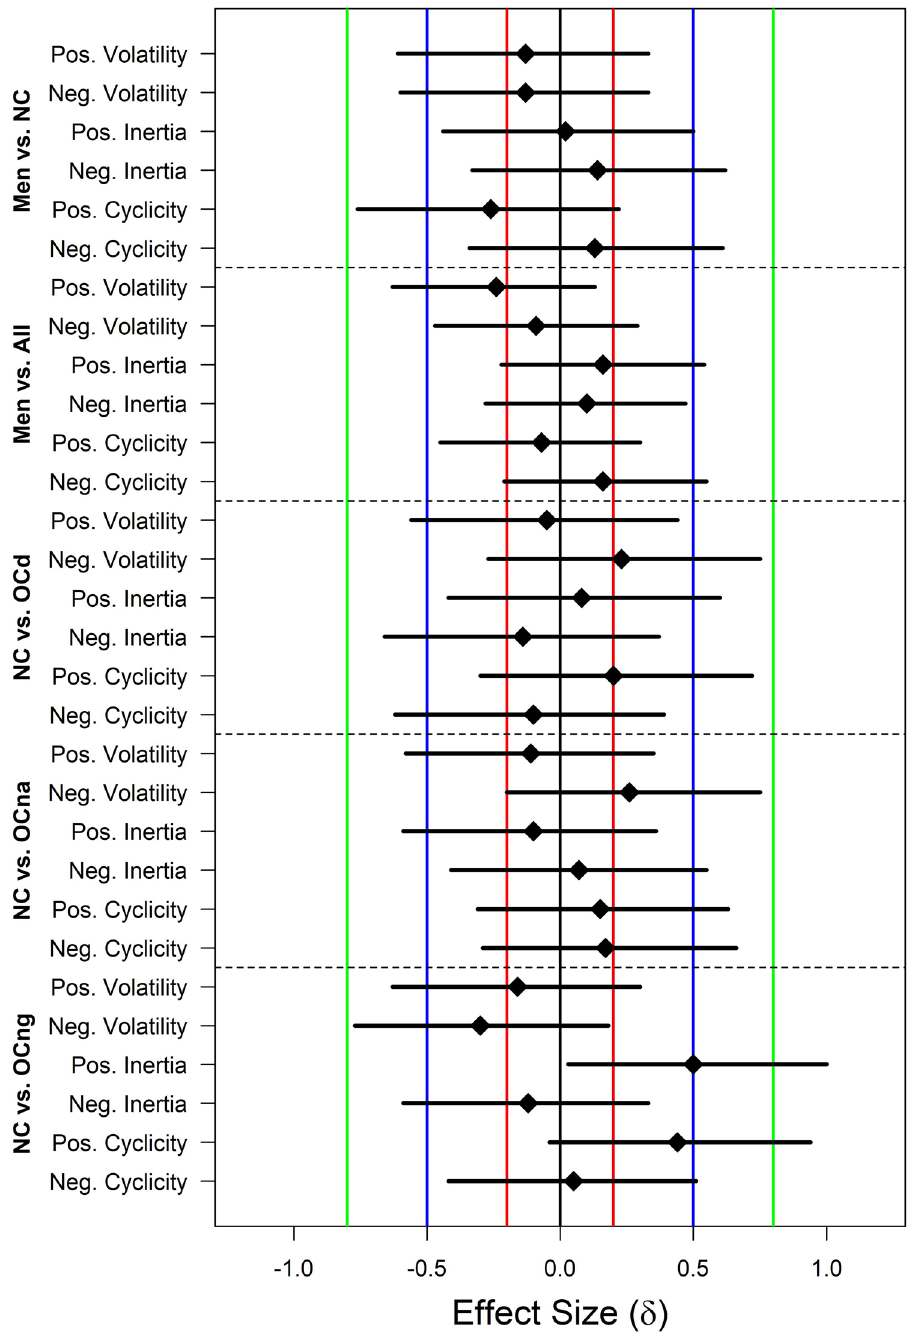
Figure 4. Graphical summary of the medians (diamonds) and credible intervals (CIs; solid black lines) of posterior distributions for effect size (δ) from all Bayesian t -tests of group differences in indices of affective variability. The dark gray line in the center indicates an effect size of 0, while the colored lines indicate δ values commonly labeled as “small” (red: δ =|0.20|), “medium” (blue: δ =|0.50|), and “large” (green: δ =|0.80|). NC, naturally cycling women; OCd, OC users of pills with ethinyl estradiol and drospirenone; OCna, OC users of pills with ethinyl estradiol and norethindrone acetate; OCng, OC users of pills with ethinyl estradiol and